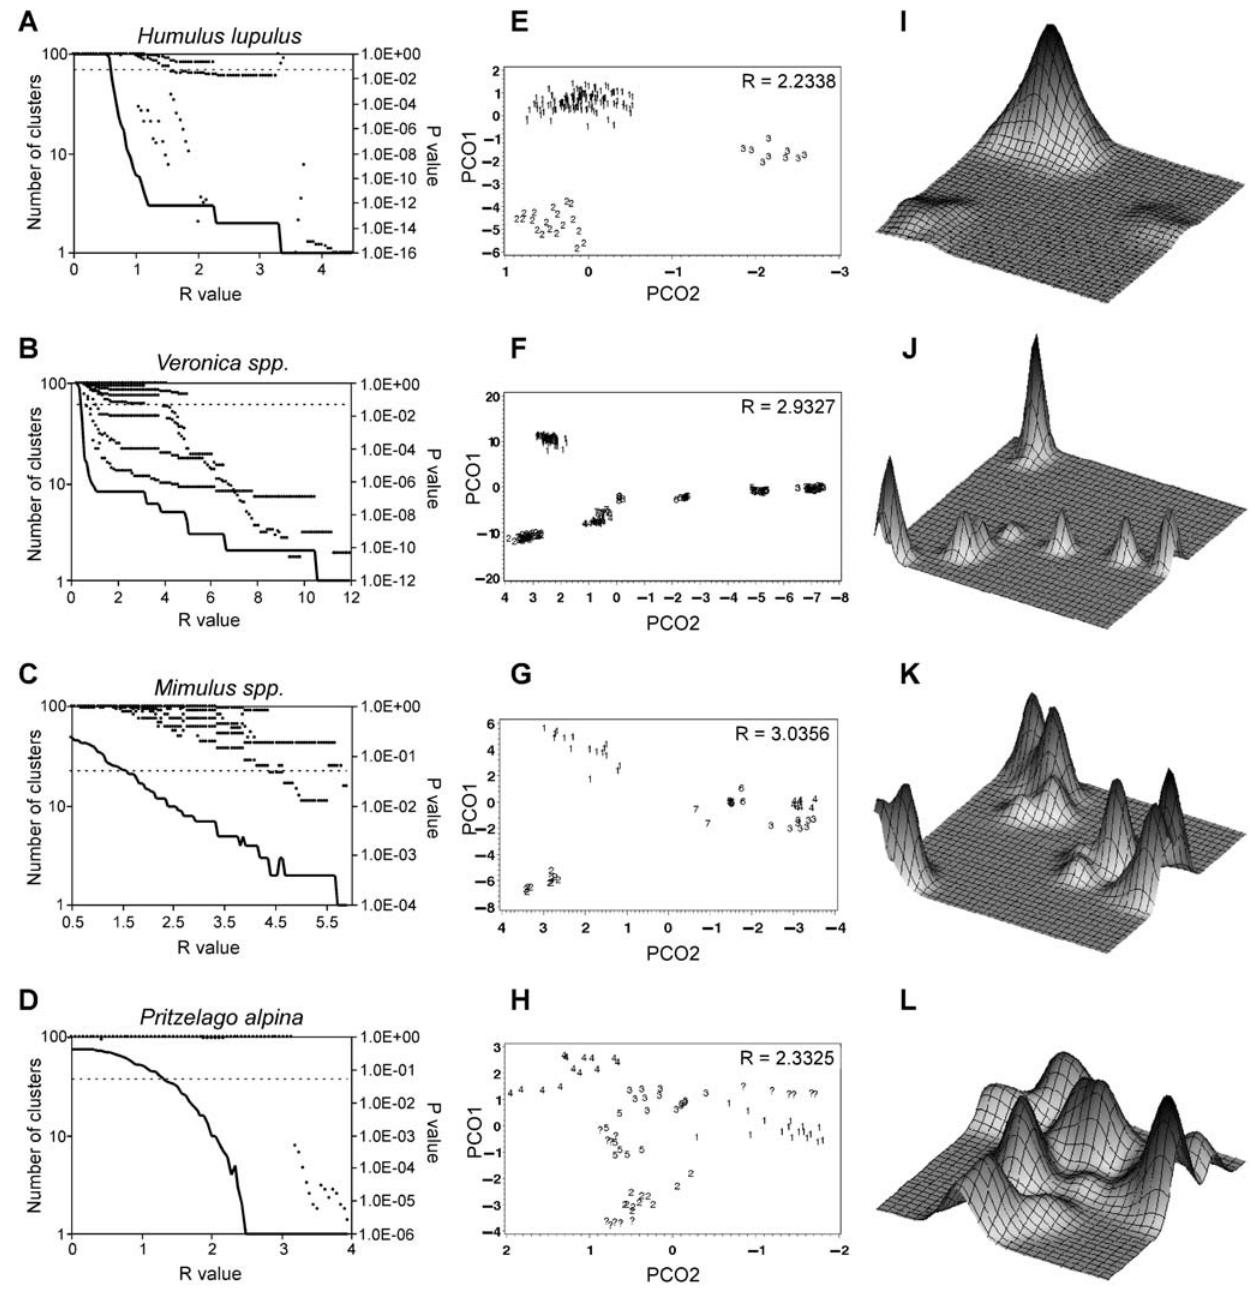
Figure 2. Density clustering of principal coordinates using four exemplar data sets. A–D) Relationship between p-value and the number of clusters inferred across R-space. Significant p-values (points below dotted line at p=0.05) are found when cluster number (solid line) is insensitive to changes in R. E–H) Plots of first two principal coordinate axes. The positions of individuals are labeled according to the assignment made by PCO-MC for the single value of R shown, but using all possible axes. I–L) Representative density landscapes inferred from the first two principal coordinate axes and a single R value.